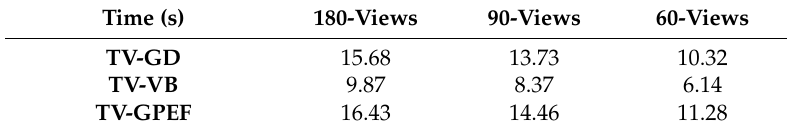
Table 4. Computation cost for the reconstruction from limited-angle circular scanning.